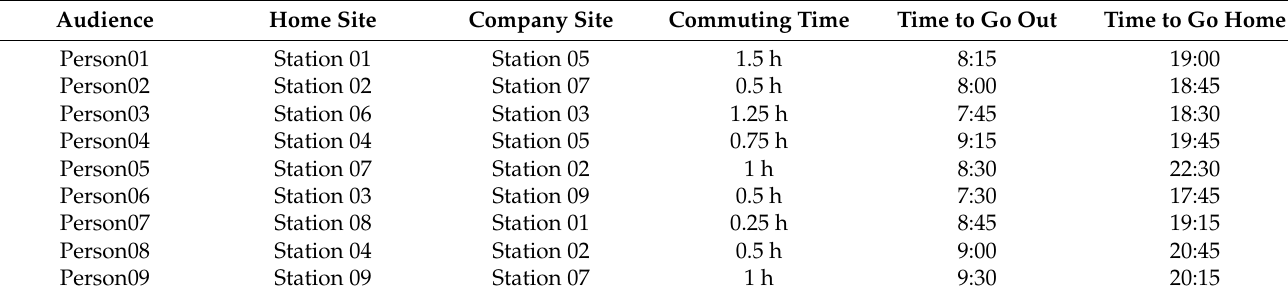
Table 8. Audience’s home and company locations and commuting schedule information.